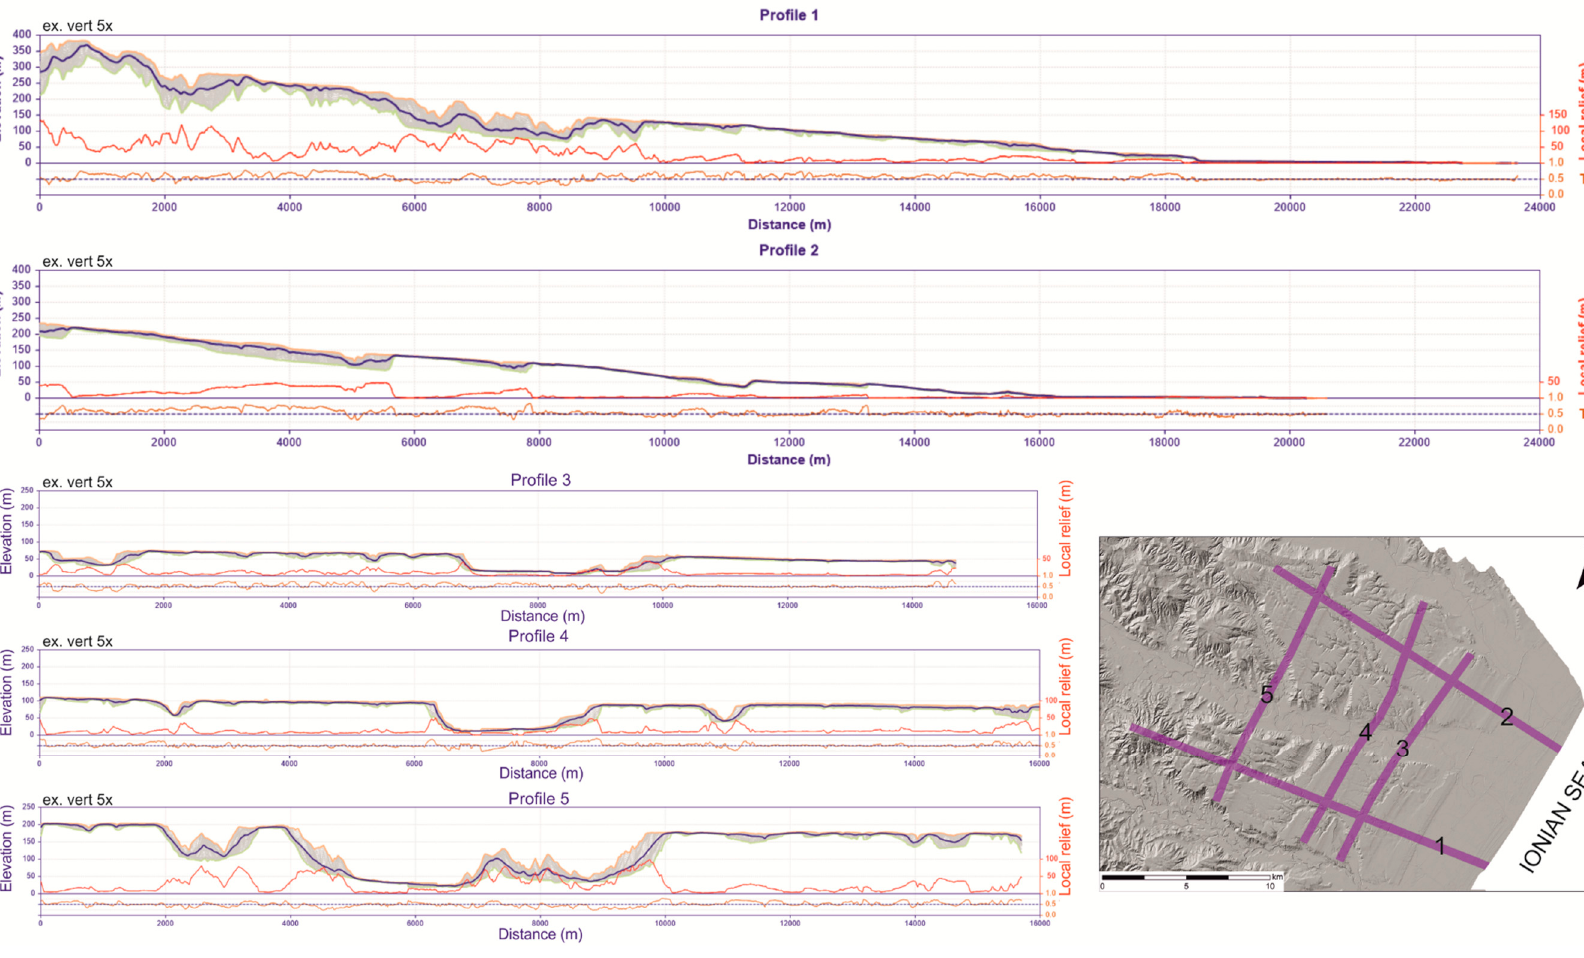
Figure 3. Swath profiles (width of 500 m) extracted transversally and longitudinally to the staircase of the marine terraces by using a 5 m DEM. Transverse Hypsometric Integral (THi, [33]) is estimated through the normalization of the hypsometric integral by the local relief.